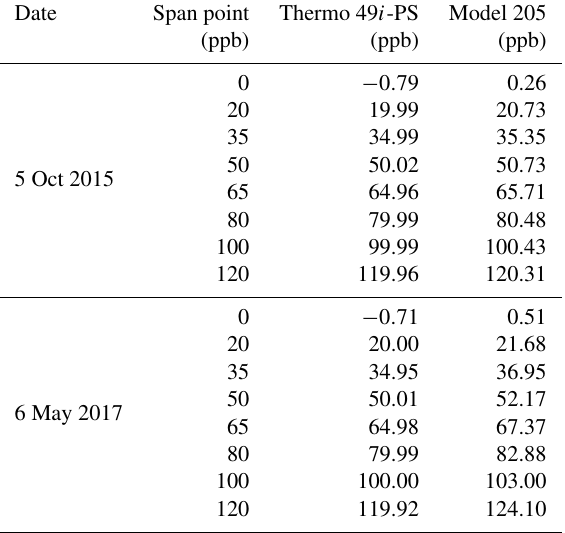
Table 1. The calibration record of the ozone monitor.